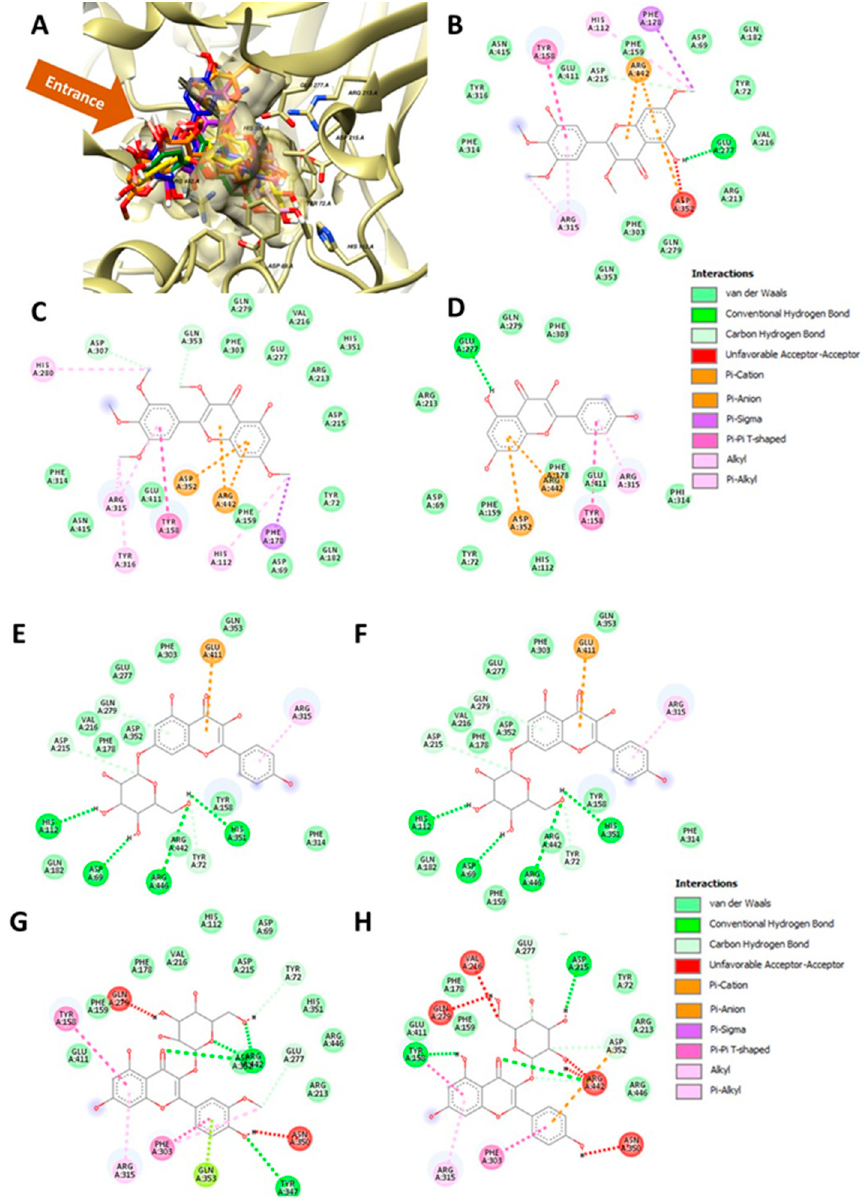
Figure 5. Molecular interactions of the obtained flavonoids from S. stramonifolium and alpha- glucosidase. ( A ) Three-dimensional diagram of all docked flavonoid molecules at the entrance of the active site of alpha-glucosidase. ( B – H ) Two-dimensional diagrams of molecular interactions of myricetin 3, 4 ′ , 5 ′ , 7-tetramethyl ether (compound 1 , ( B )), combretol (compound 2 , ( C )), 5-hydroxy 3-7-4 ′ -5 ′ -tetramethoxyflavone-3 ′ - O -glucopyranoside (compound 5 , ( D )), kaempferol (compound 3 , ( E )), kaempferol-7- O -glucopyranoside (compound 4 , ( F )), isorhamnetin-3- O -glucopyranoside (compound 6a , ( G )), and astragalin (compound 6b , ( H )), and amino acid residues at the catalytic site of alpha-glucosidase. Table 4. Molecular interactions between amino acid residues from alpha-glucosidase and compounds of interest and conserved residues.